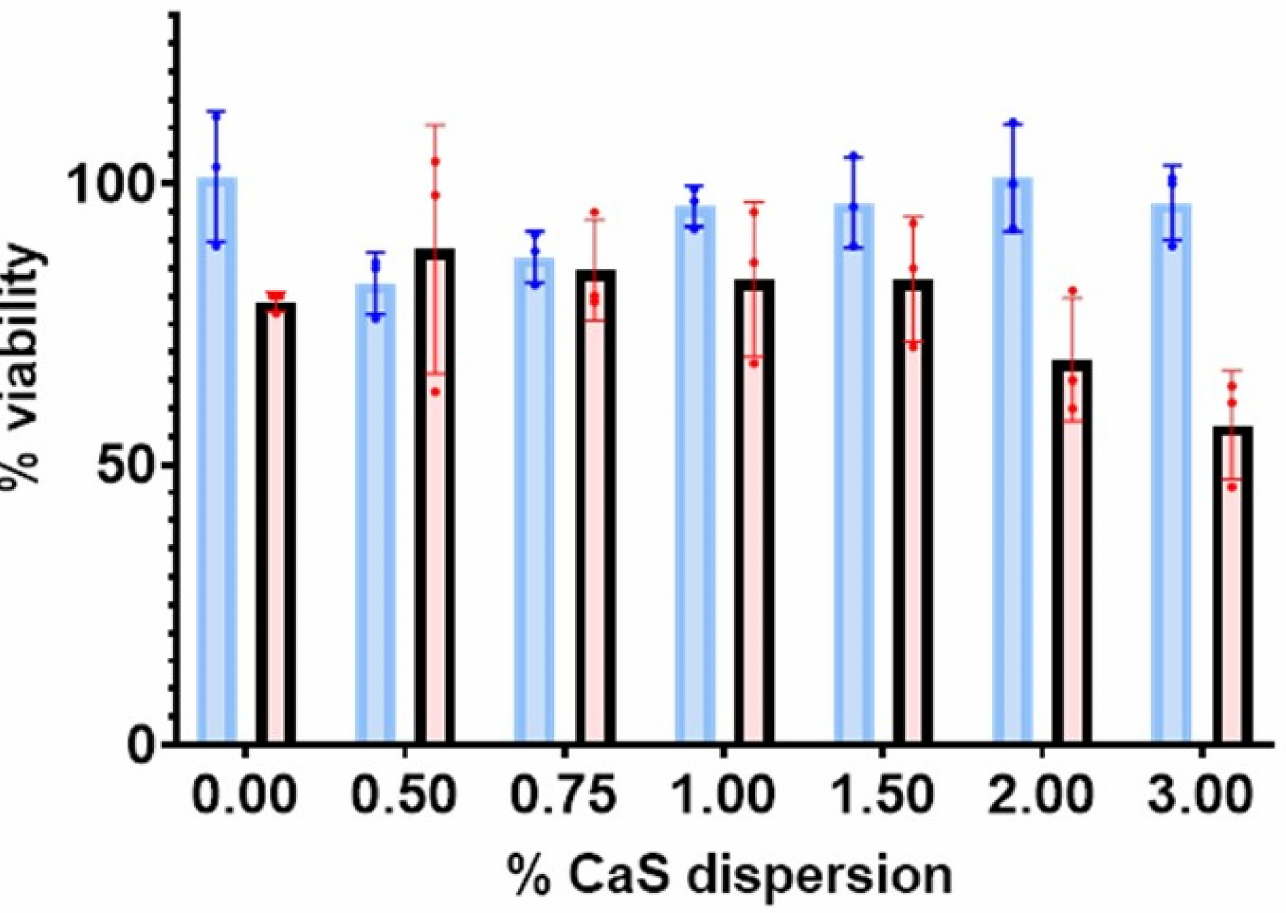
Figure 1. The percentage of live malignant (red) and benign fibroblasts (blue) as a function of the percentage (%) of CaS dispersion